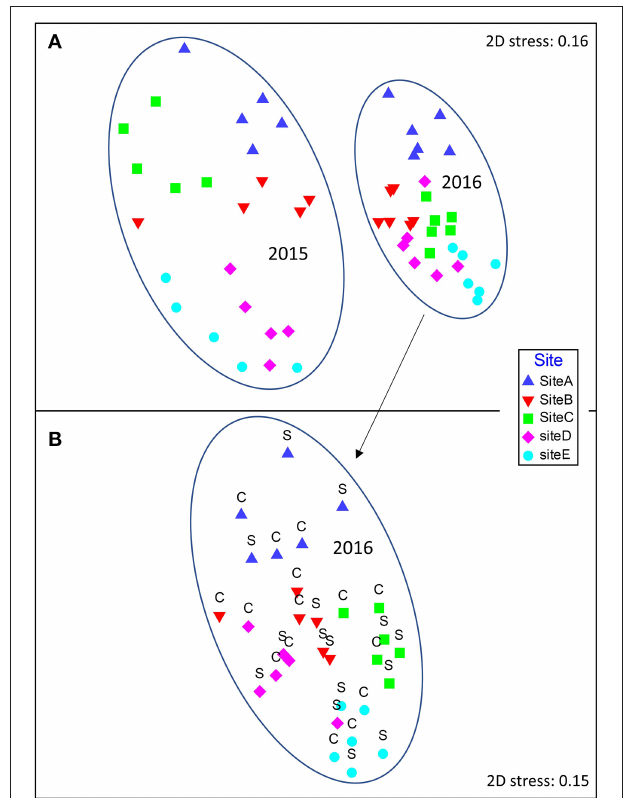
FIGURE 2 | Non-metric multidimensional scaling (nMDS) plot of Bray-Curtis similarities based on log(x + 1) transformed sediment invertebrate community sample data (organisms ≥ 0.125mm). Points closer to one another in ordination space are more similar than those apart. The five sites in Mahurangi Harbor are indicated with different symbol colors and shapes (see legend on figure). (A) Data from the five sites in both years, (B) data from the five sites in 2016 only, with structured and control plot samples indicated by S and C, respectively. Stress value is an indication of how well the multivariate data are represented in two